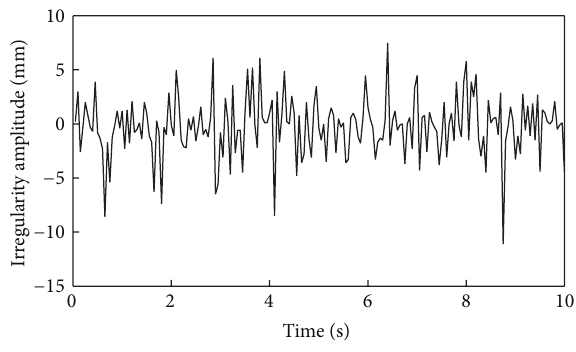
Figure 2: Track random